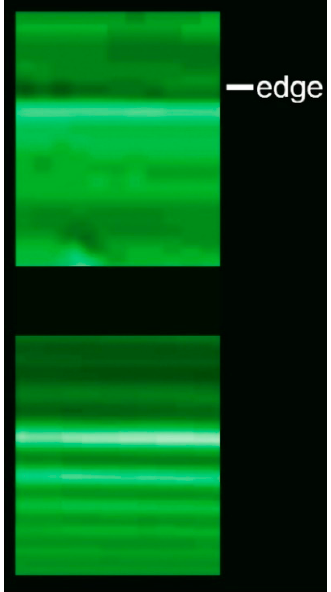
Figure 7. Two radiographs of the edge of an optics fiber, taken with coherent X-rays for two different object-detector distances, r o = 0.25 m (top image) and r o = 1.4 m [15,16]. Edge enhancement due to refraction dominates in the first case, whereas Fresnel edge diffraction accounts for the fringe sequence in the second.